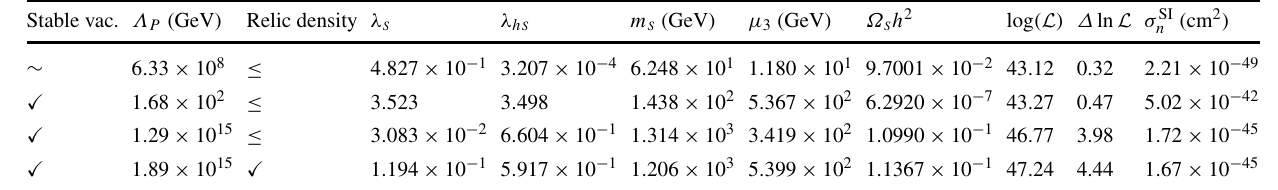
of the Planck observed value ( Ω S h 2 ∼ Ω DM h 2 ) are indicated with a tick in the third column. We omit the values of the nuisance parame- ters, as they are not significantly different to the central values of their respective likelihood functions